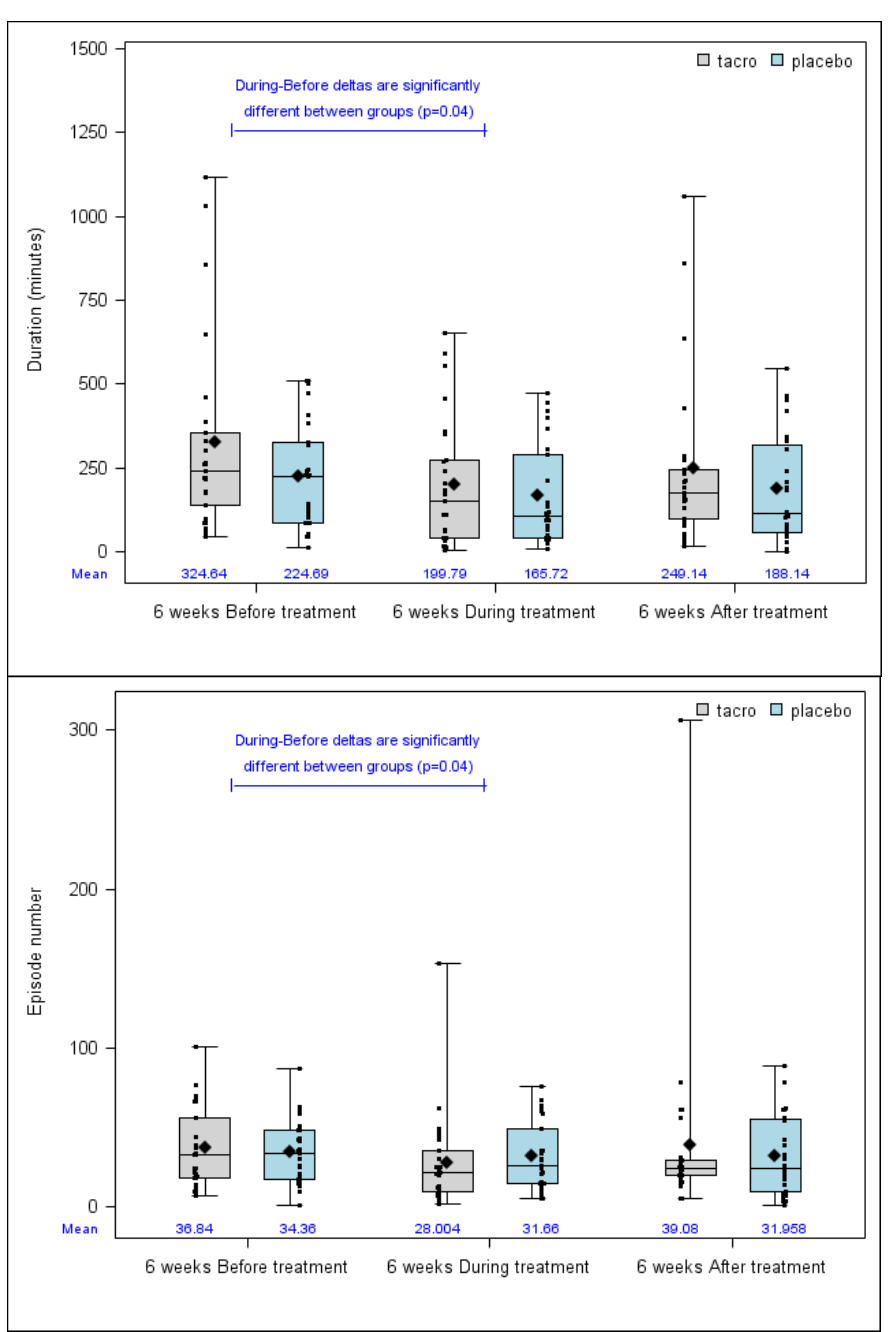
Figure 2. Mean epistaxis duration and number on six weeks before, during and after treatment. Legends: Lines from bottom to top: minimum, 25th percentile, median, 75th percentile and maximum. Diamond: mean. Small squares: individual data.